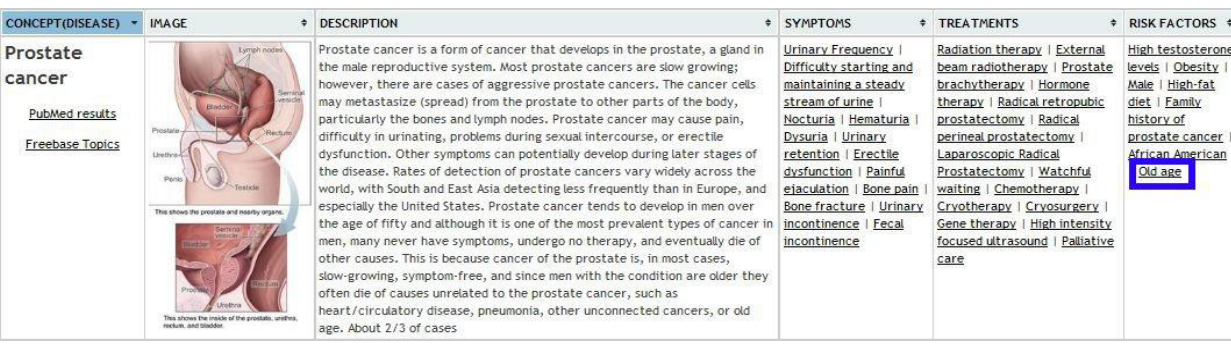
Figure 10. Relevant entity recognition from Freebase for